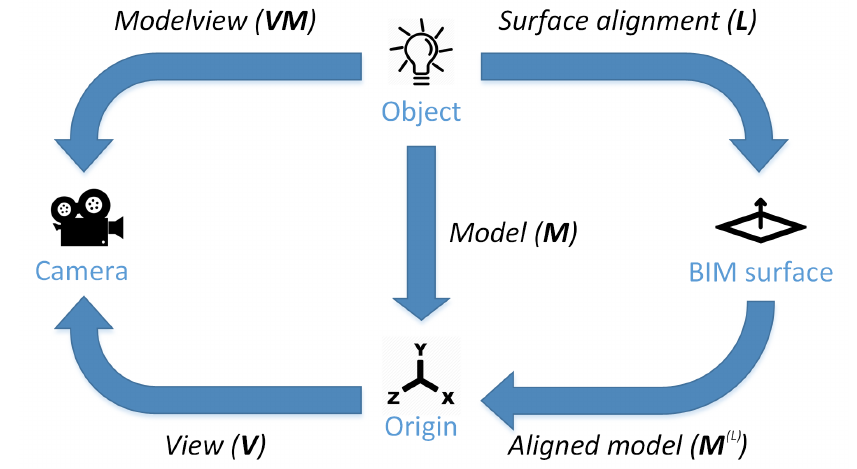
Figure 3. Transformations between coordinate systems involved in the detection